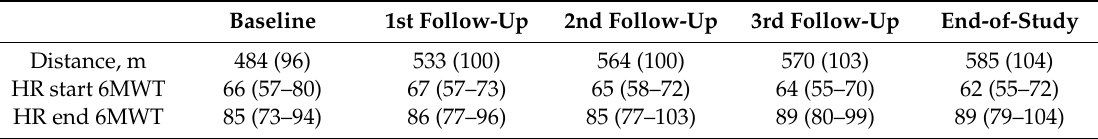
Table 3. Output 6MWT at five di ff erent time points during